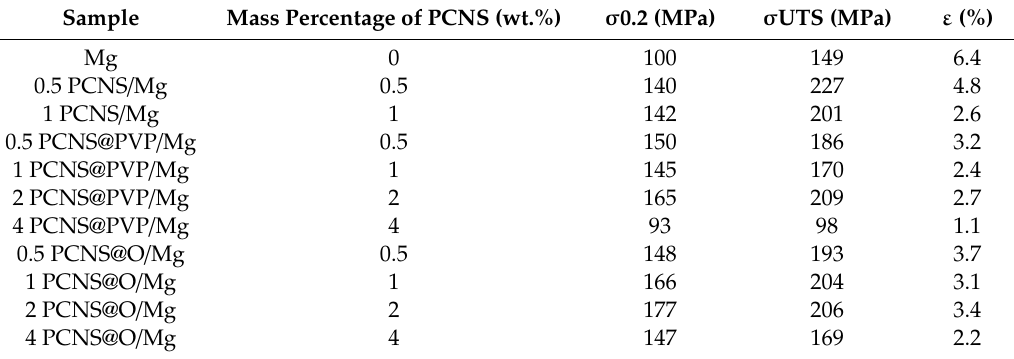
Table 3. Tensile yield and ultimate tensile strength of PCNS-reinforced Mg composites.